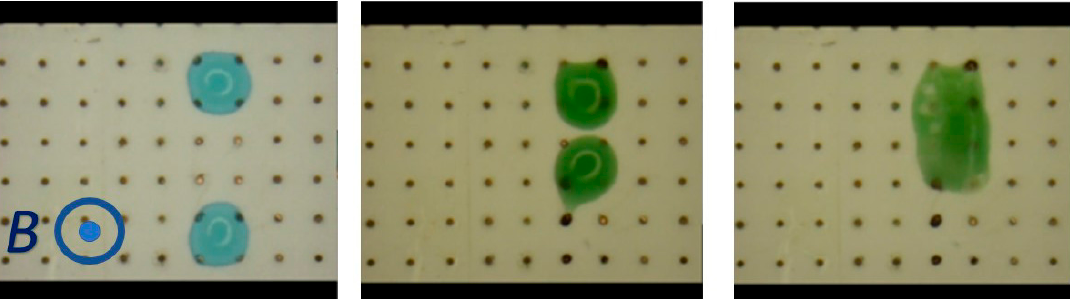
Figure 6. Digital microfluidics with MHD. The device’s surface is patterned with individually controlled electrodes. The device is exposed to a magnetic field provided by a permanent magnet. When a potential difference is applied to pairs of electrodes at the drops’ locations, the resulting current interacts with the magnetic field to produce Lorentz forces, causing the drops to migrate. This image depicts two drops migrating towards each other until they fuse. By judicious programming of the electrodes, one can move droplets along any desired path, induce stirring in the drops, cause two or more drops to fuse, and split drops (unpublished work).